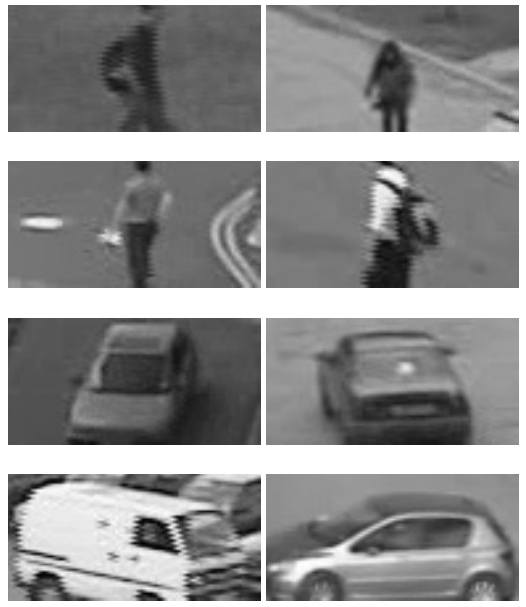
Figure 6: Some images [14] in the collection of data.